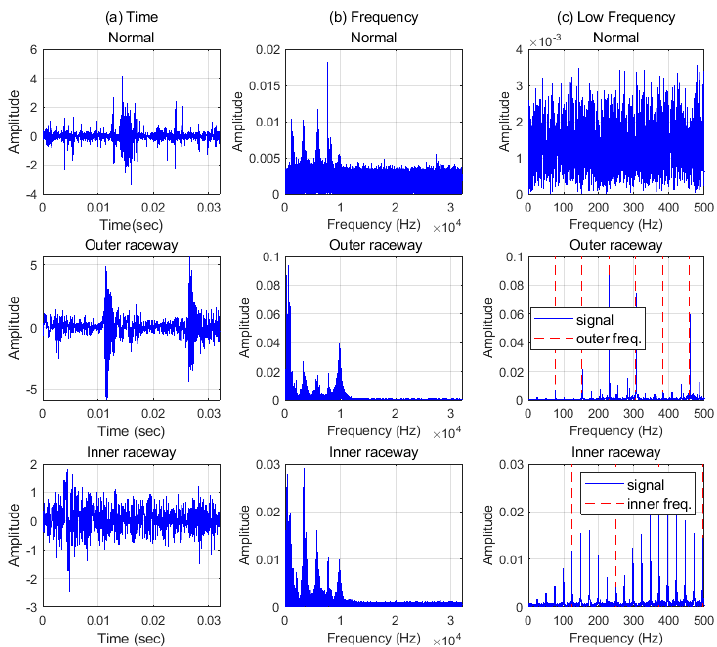
Figure 7. PU data in ( a ) time, ( b ) frequency, ( c ) low frequency domain. The red dash lines are the characteristic frequencies and their harmonics. 𝐵𝑃𝐹𝑂 = 76.36 Hz , 𝐵𝑃𝐹𝐼 = 123.64 Hz.